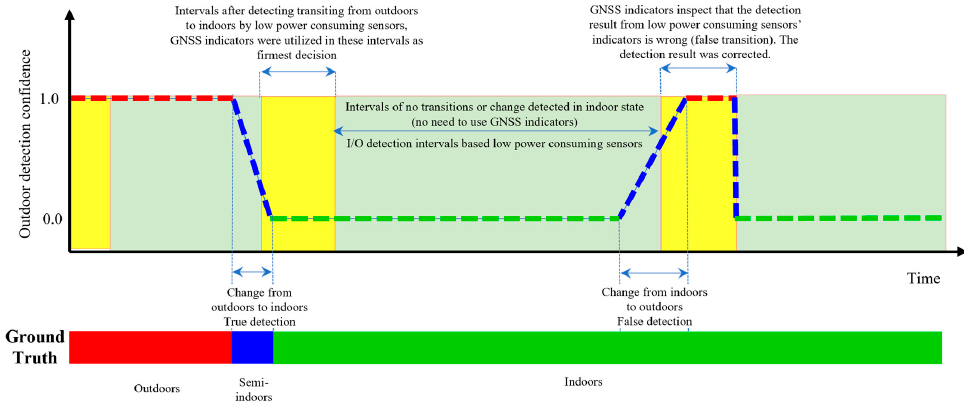
Figure 4. Utilizing GNSS and LPCS indicators in the proposed I/O detection